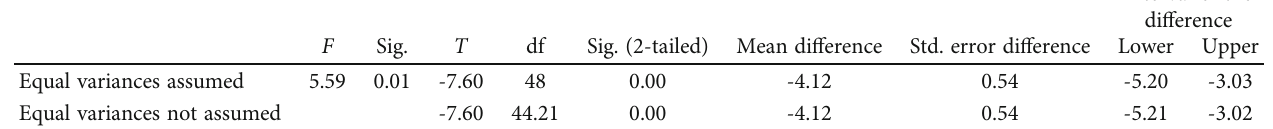
Table 7: Independent sample t -test (the delayed posttests of both groups). Levene ’ s test for equality